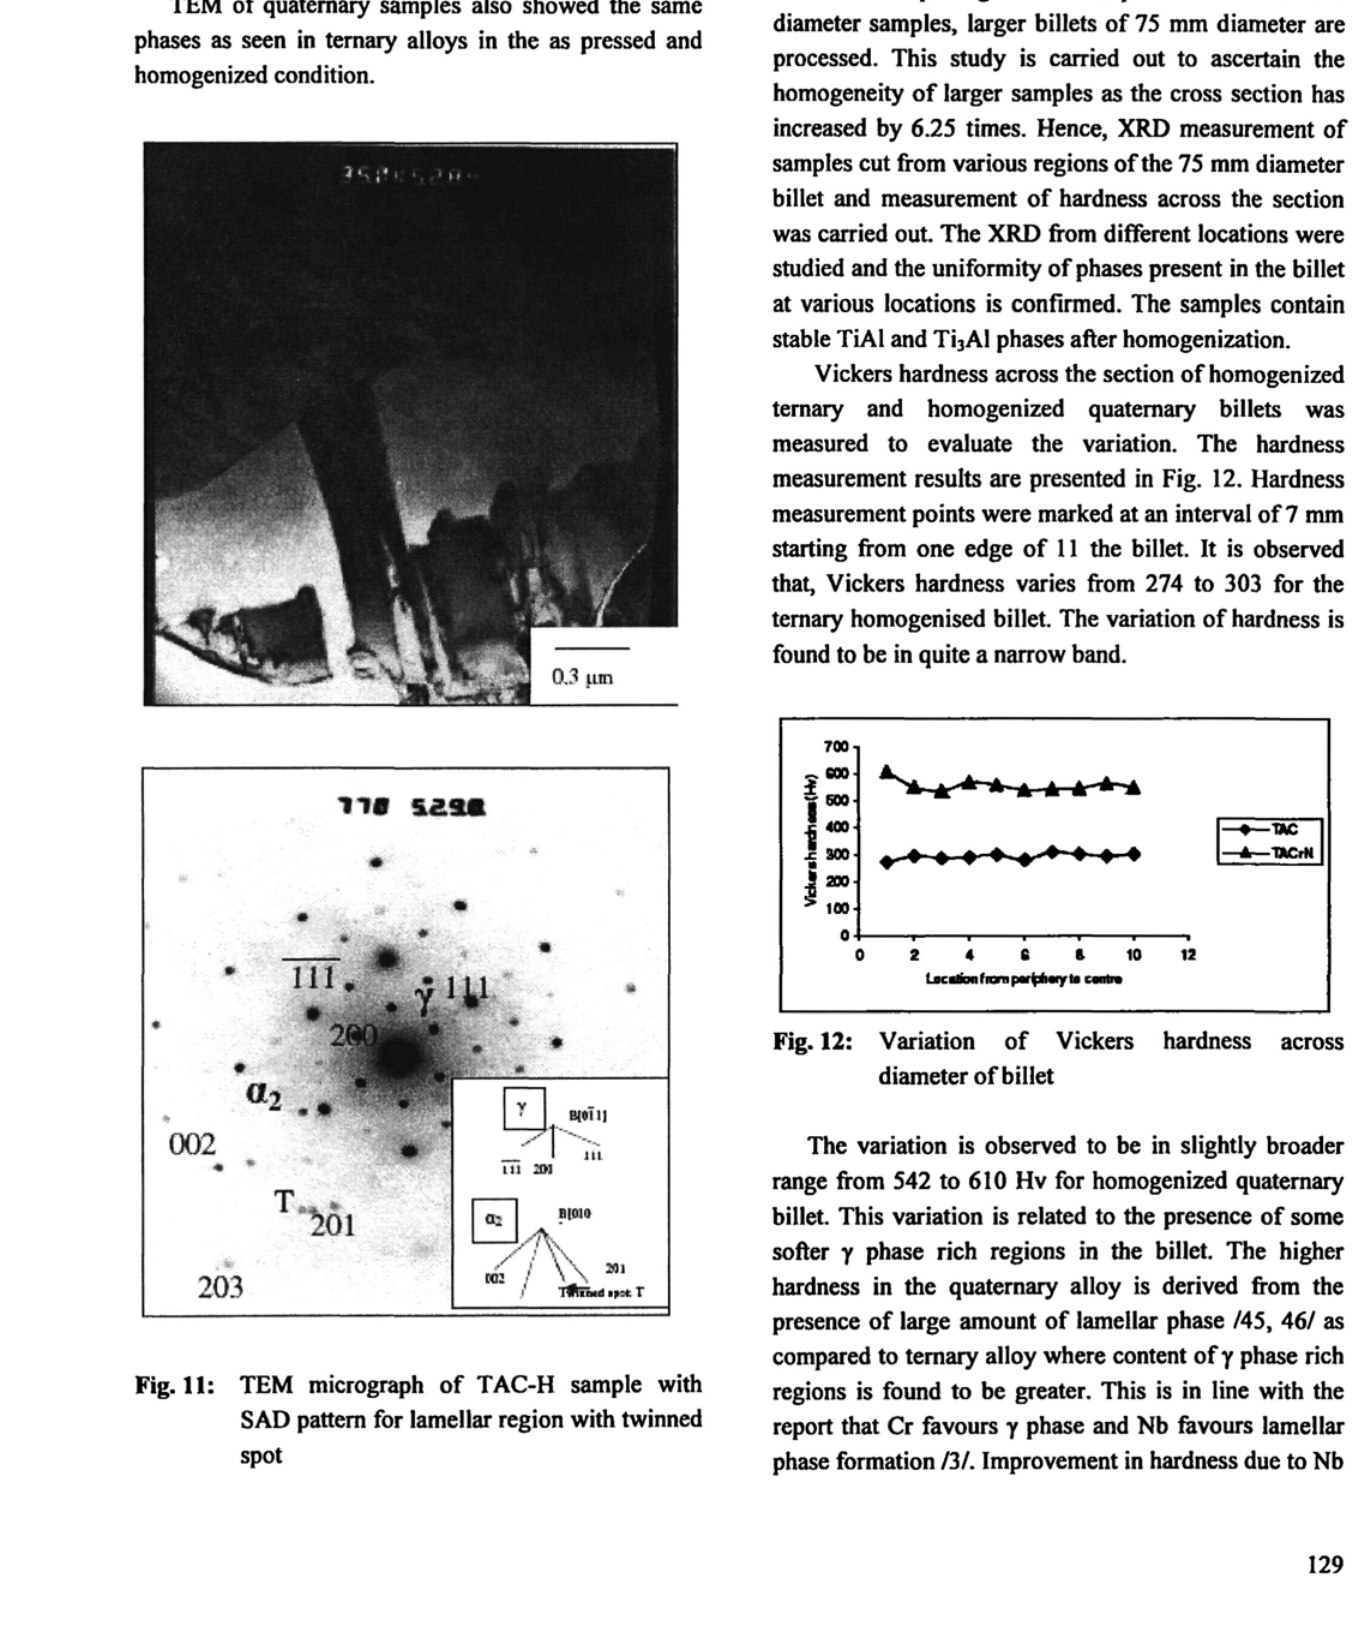
Fig. 12: Variation of Vickers hardness across diameter of